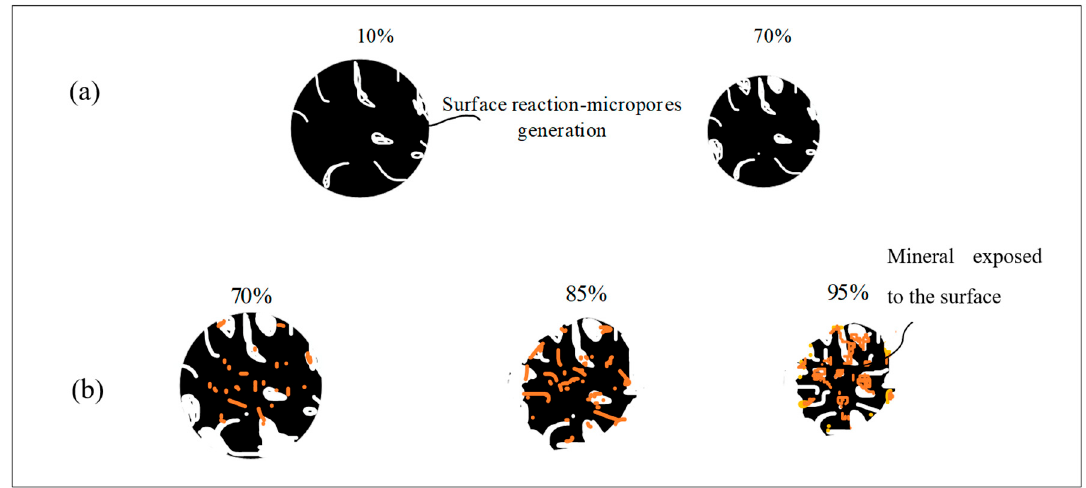
Figure 16. Simplified schematic representation of char conversion in steam atmosphere. ( a ) Progression of char conversion. ( b ) The role of K at higher char conversion.